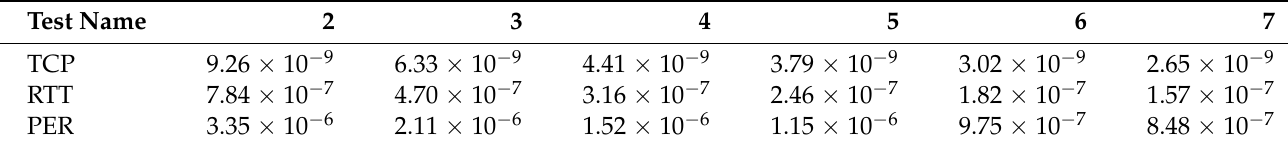
Table 5. Bit efficiency η B .